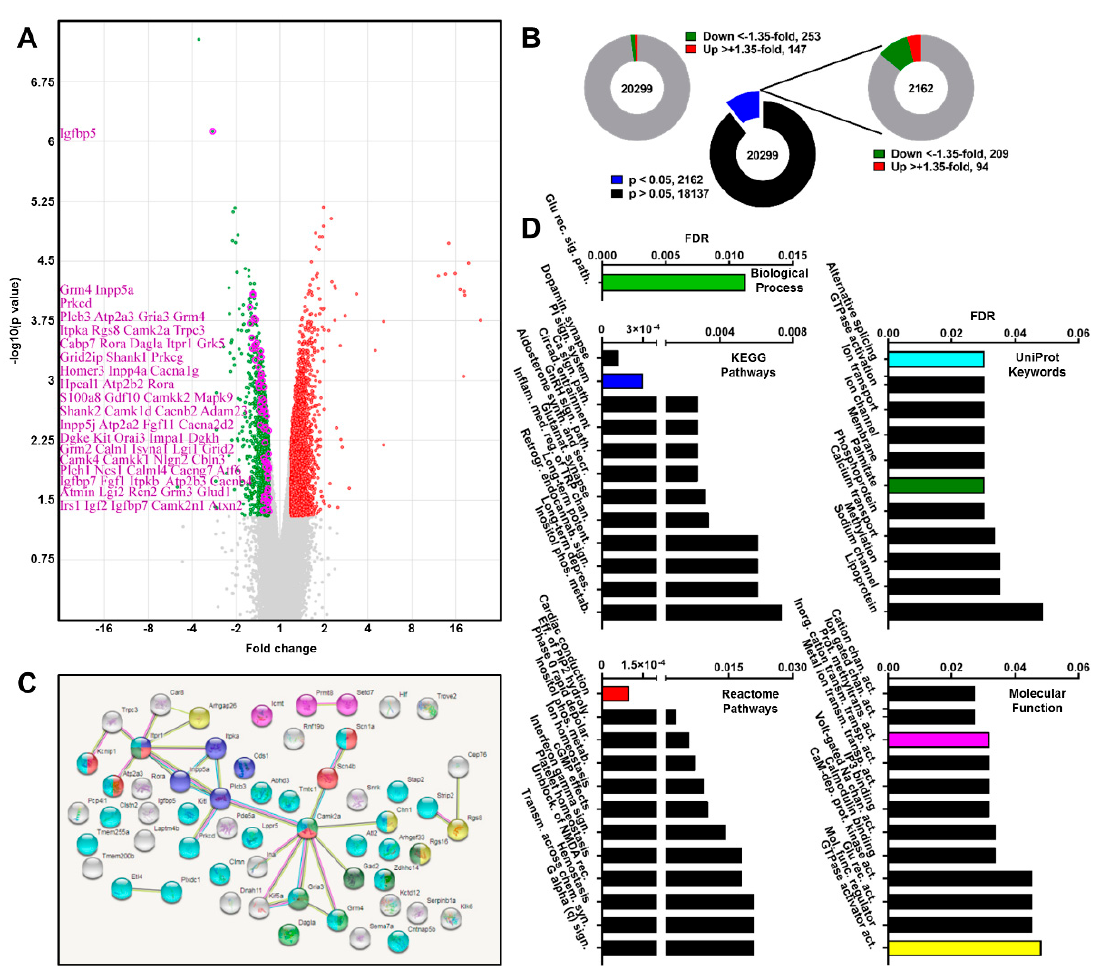
Figure 1. Global transcriptome profile of Atxn2 -CAG100-KIN mouse cerebellum at pre-onset stage. ( A ) Volcano plot analysis of all the quantified mRNAs showing significant up- or downregulations beyond 20% fold-change in red and green, respectively. Highly significant and cerebellar pathology- relevant transcripts among downregulations are colored in magenta. Transcriptome analysis was performed with Affymetrix Clariom D oligonucleotide microarray technology, comparing 3 Atxn2 - CAG100-KIN cerebellum samples with 3 age- and sex-matched WT controls. Statistical assessment of